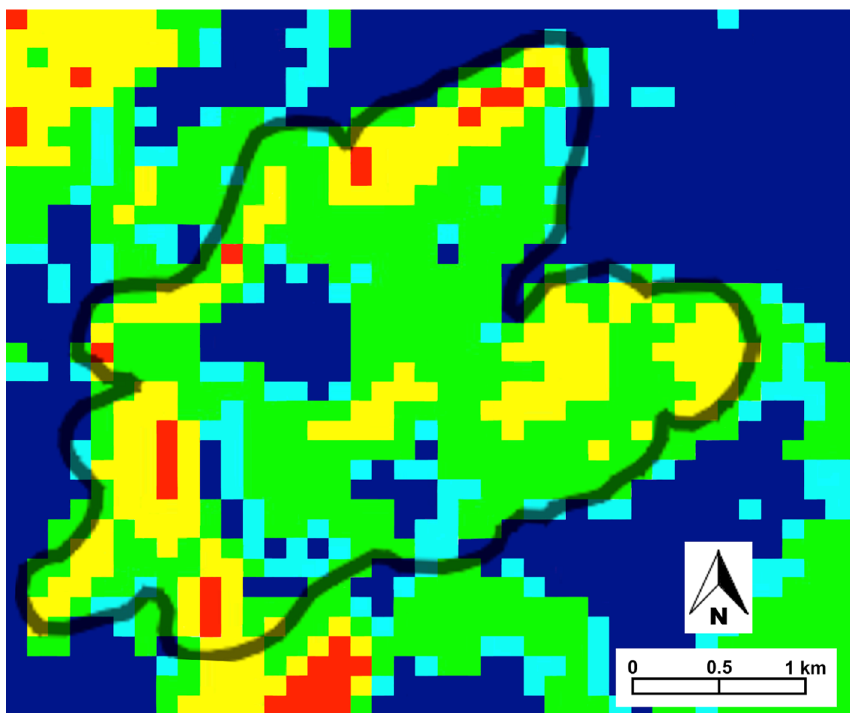
Figure 11. Average pixel-integrated particle size map of the North Coulee 972 flow derived from extensive field measurements and related back to the calculated ATI, with blue (<1 cm), cyan (1 cm–3 cm); green (3 cm–500 cm); yellow (500 cm–1.0 m); and red (>1 m). The approximate flow boundary is shown by the black outline. Map created from ATI image.